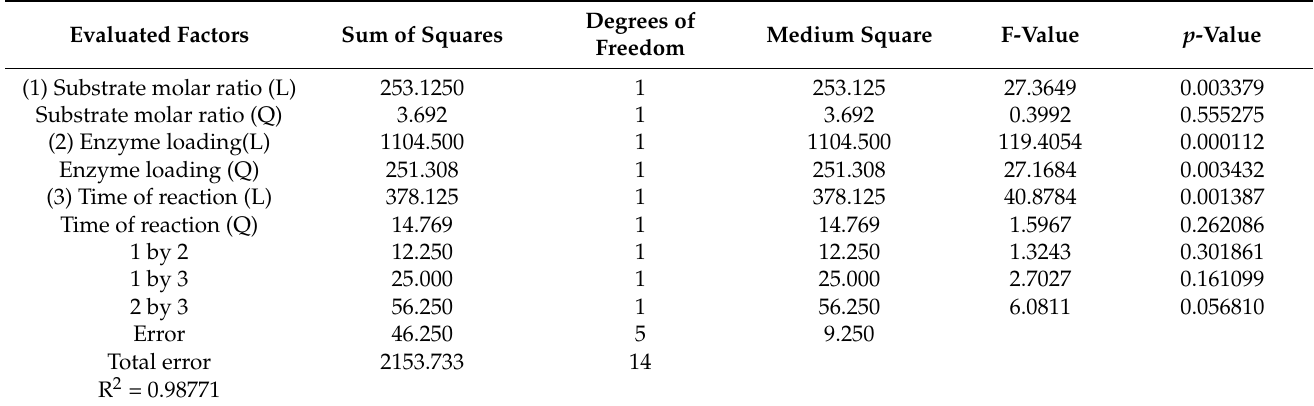
Table 2. Analysis of variance (ANOVA) for acidolysis variables pertaining to the response of percent incorporation of 3-OMe-CA into PC/LPC.